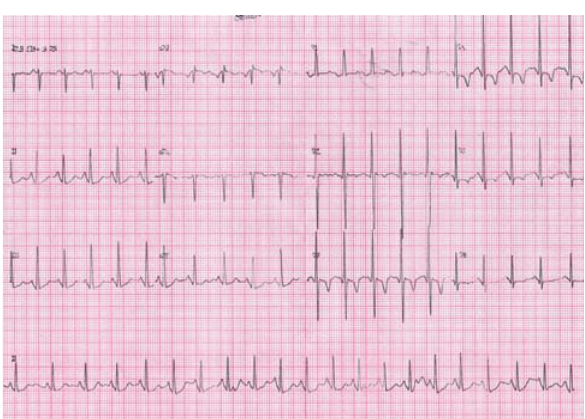
Fig. 1 – Eletrocardiograma pré-operatório com importante sobrecarga ventricular